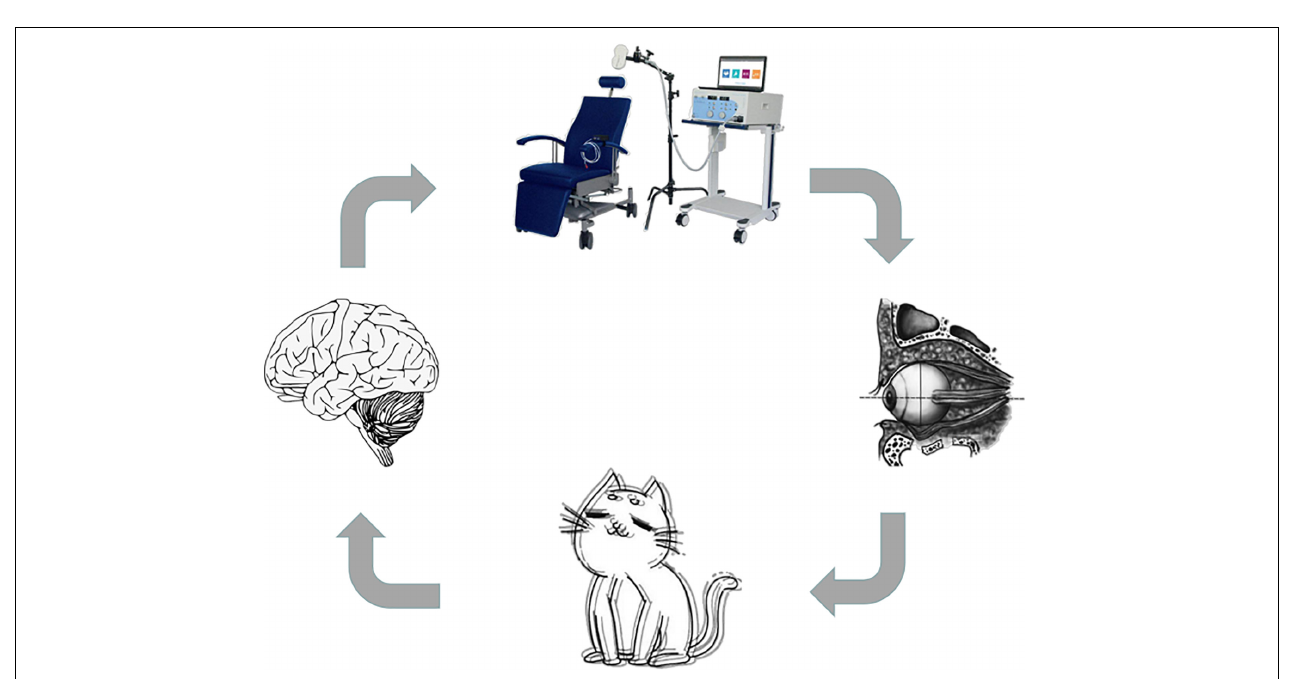
FIGURE 6 | Relationship between rTMS and diplopia. Patients with SA may develop diplopia after surgery. Once diplopia occurs, visual function may be affected, leading to abnormal neural activity in brain regions. SA, oblique amblyopia disease.